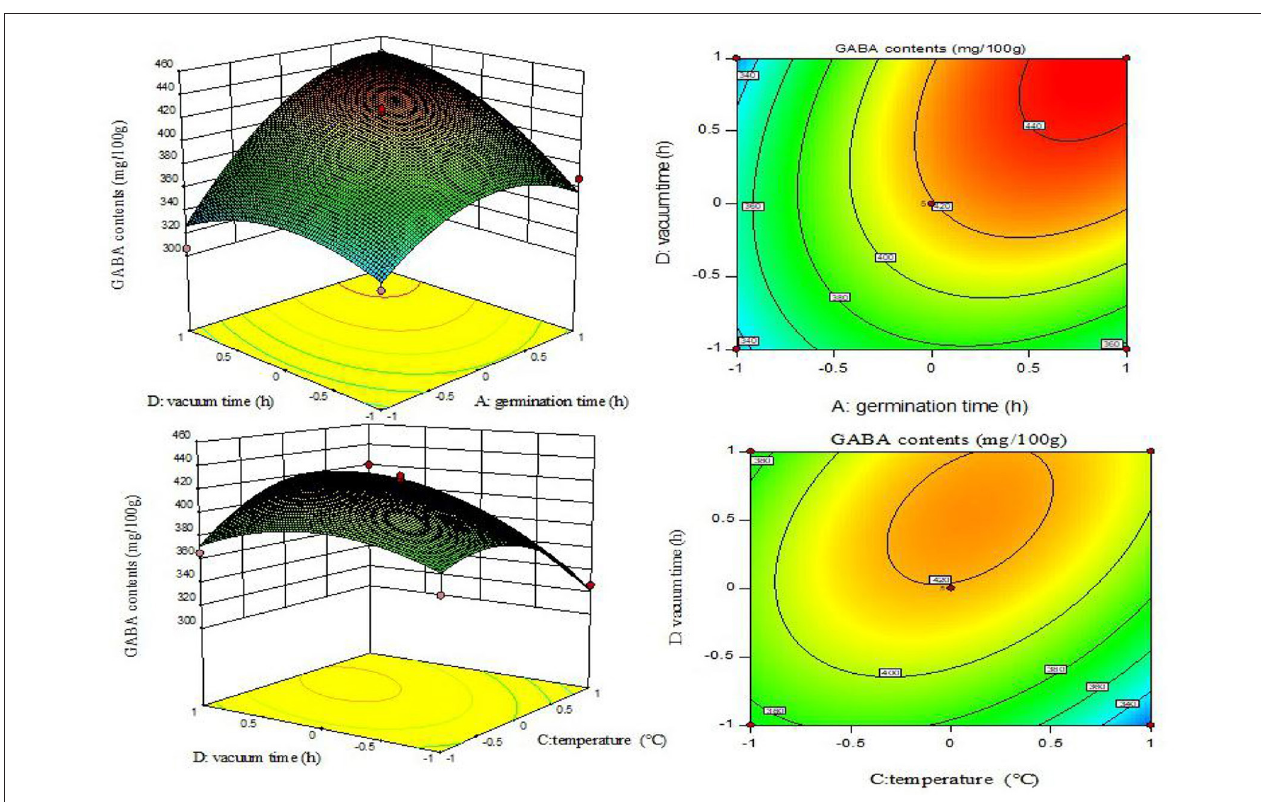
FIGURE 3 | Contour lines and response surface diagrams of the interaction between AD and CD.